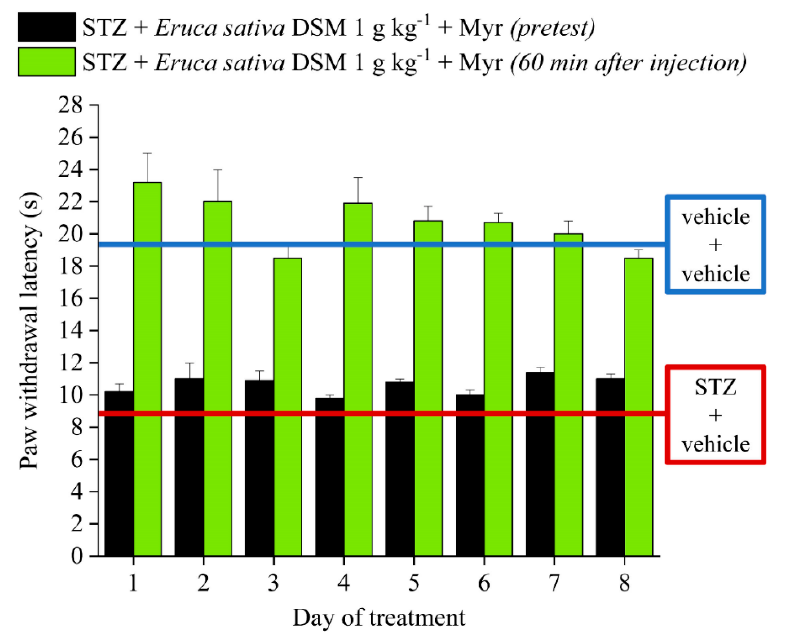
Figure 2. Effect of acute administration of bioactivated glucoerucin (GER) on streptozotocin (STZ)-induced neuropathic pain. The response to both a mechanical and a thermal stimulus was evaluated by measuring the latency (s) to pain-related behaviors; ( a ) withdrawal or ( b ) licking of the paw. GER (30–100 µkg − 1 ) was bioactivated by adding 30 µL mL − 1 of myrosinase (32 U mL − 1 ) 15 min before the oral administration in STZ-treated animals. Tests were performed 30, 60, 90, and 120 min after the injection. ^^ p < 0.01 versus vehicle + vehicle-treated mice; * p < 0.05 and ** p < 0.01 versus STZ + vehicle-treated mice.